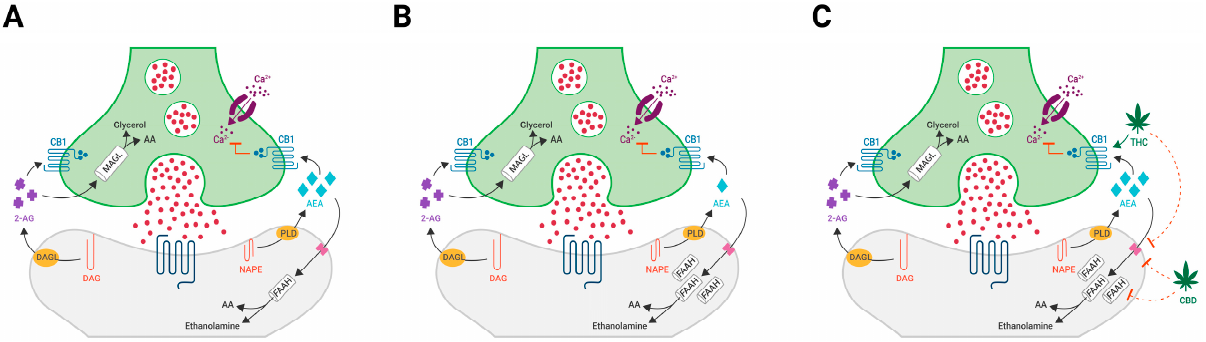
Figure 1. A series of diagrams illustrating the production of endogenous cannabinoids 2-AG and AEA from precursor molecules, their mechanism of action at the presynaptic CB1 receptors (with the resultant effect of reduced presynaptic calcium influx and hence neuronal excitement), and subsequent degradation by FAAH and MAGL. ( A ) Normal ECS functioning; ( B ) the ECS in EUPD showing an increase in FAAH-mediated degradation of AEA; ( C ) potential exogenous cannabinoid mechanism of action at the presynaptic CB1 receptor and at the postsynaptic deactivation of